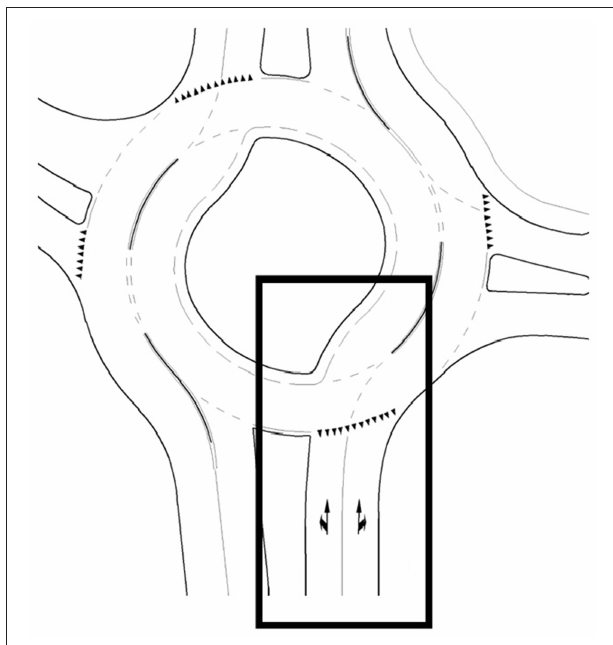
FIGURE 1 | Traffic control scheme for turbo roundabout entry at which measurements were made.